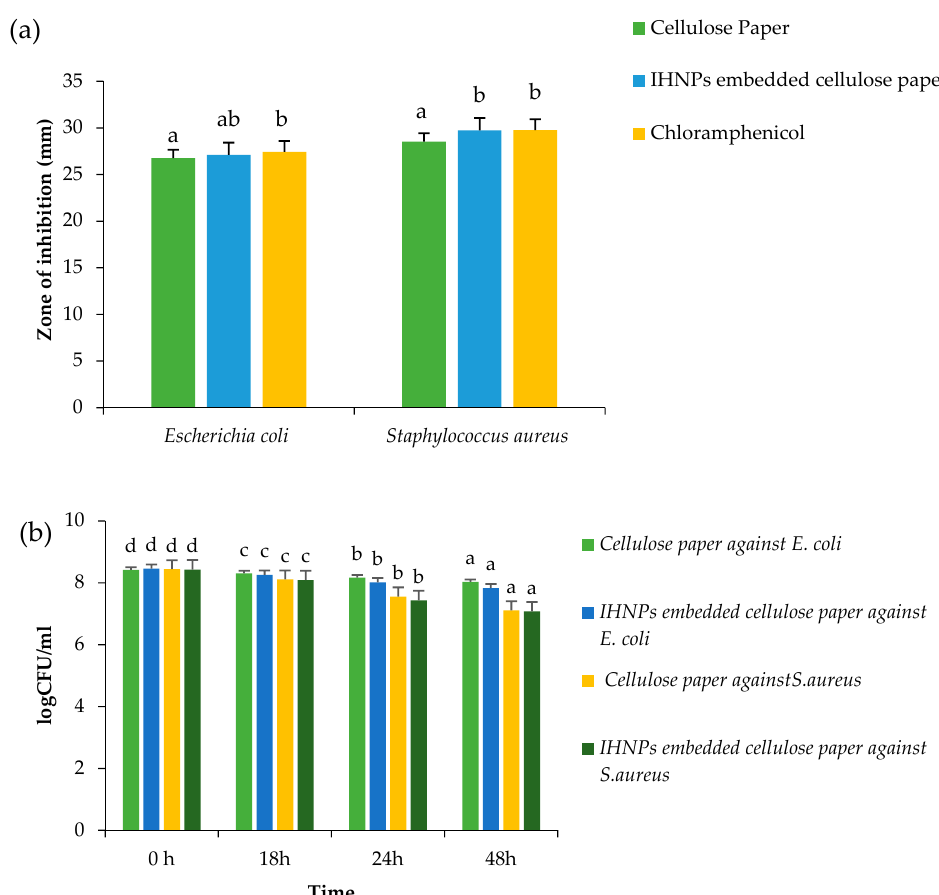
Figure 6. ( a ) Zone of inhibition ( b ) Time kill study of gum arabic stabilized IHNP’s embedded cellulose paper against pathogenic microorganisms. Data are presented as means ± SEM (n = 3). a,b Means within the row with different lowercase superscript are significantly different ( p < 0.05) from each other; a–d Means within the row with different lowercase superscript are significantly different ( p < 0.05) from each other.